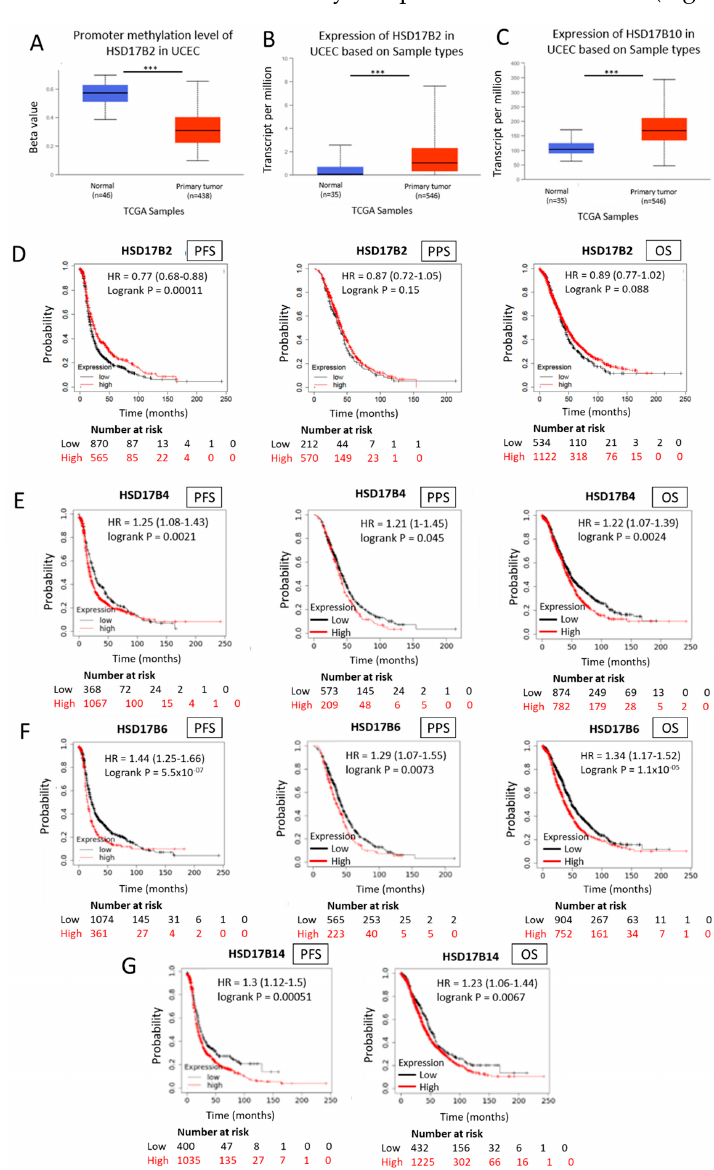
Figure 6. Expression and methylation of HSD17B enzymes involved in estrone synthesis and ovarian cancer patient outcome ( B – F ). Methylation levels of the HSD17B2 enzyme in normal and tumour tissue samples obtained from “The Cancer Genome Atlas” (TCGA) database ( A ). Expression levels of the HSD17B2 enzyme in normal and tumour tissue samples obtained from the TCGA ( B ). Expression levels of the HSD17B10 enzyme in normal and tumour tissue samples obtained from the TCGA ( C ). Kaplan– Meier curves comparing low (black line) vs high (red line) tumoural expression levels of HSD17B2, HSDD17B4 and HSD17B6 enzymes involved in E1 synthesis and progression-free survival (PFS), post- progression-free survival (PPS) and overall survival (OS) in ovarian cancer patients (HR = Hazard Ratio) ( D – F ) in the case of HSD17B14 only PFS and OS are represented ( G ). *** p <